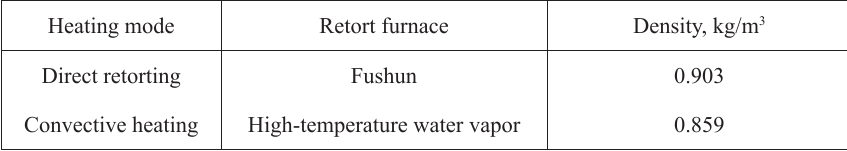
Table 3. Density of shale oil under different heating modes [23,